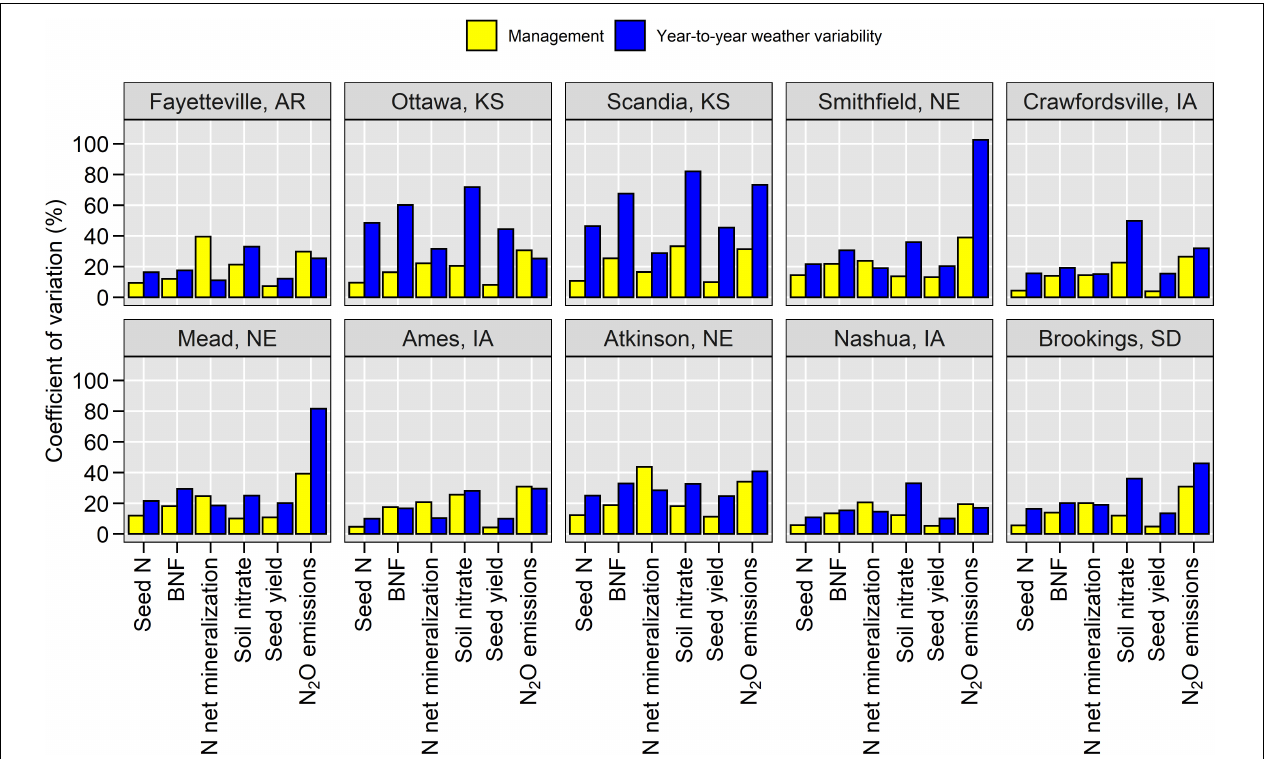
FIGURE 3 | Coefficient of variation for seed N, biological N fixation (BNF), N net mineralization, soil nitrate at harvest, seed yield and N 2 O emissions from different weather years and management scenarios across contrasting environments in the United States Corn